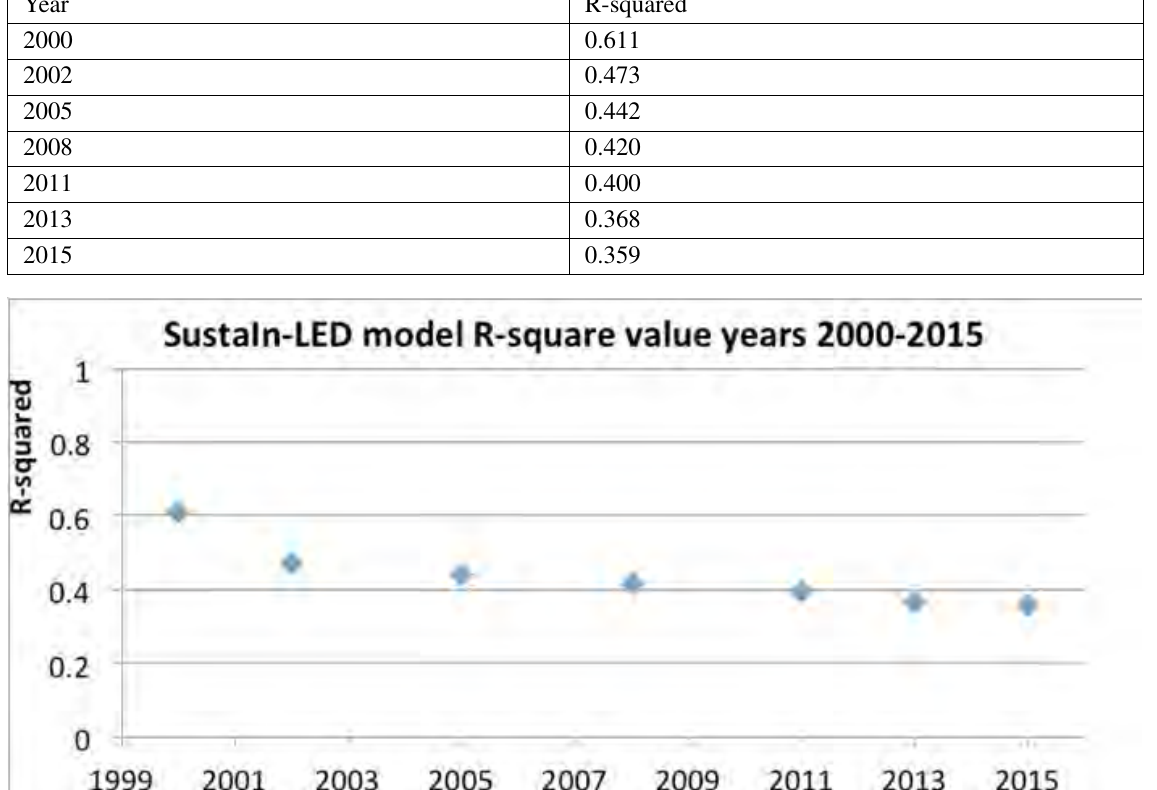
Table 6. R-squared results SustaIn-LED model for the years 2000:2015